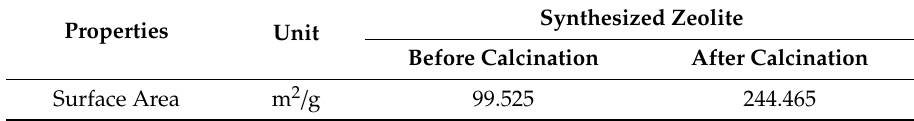
Table 4. The specific surface area of the synthesized zeolite resulted from the Brunauer–Emmett–Teller (BET) analysis.